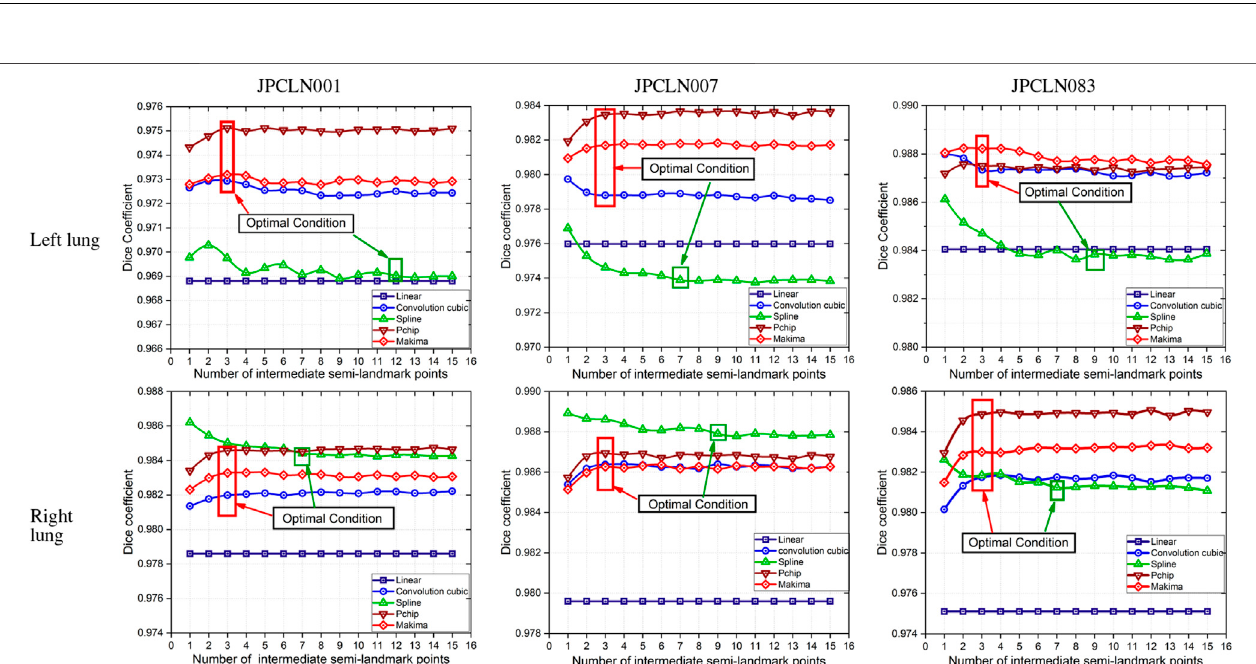
FIGURE 6 | Dice similarity coef fi cients of the modeled shape with different piecewise polynomial interpolation methods of the left and right lung fi eld regions of the image datasets JPCLN001, JPCLN007, and JPCLN083.